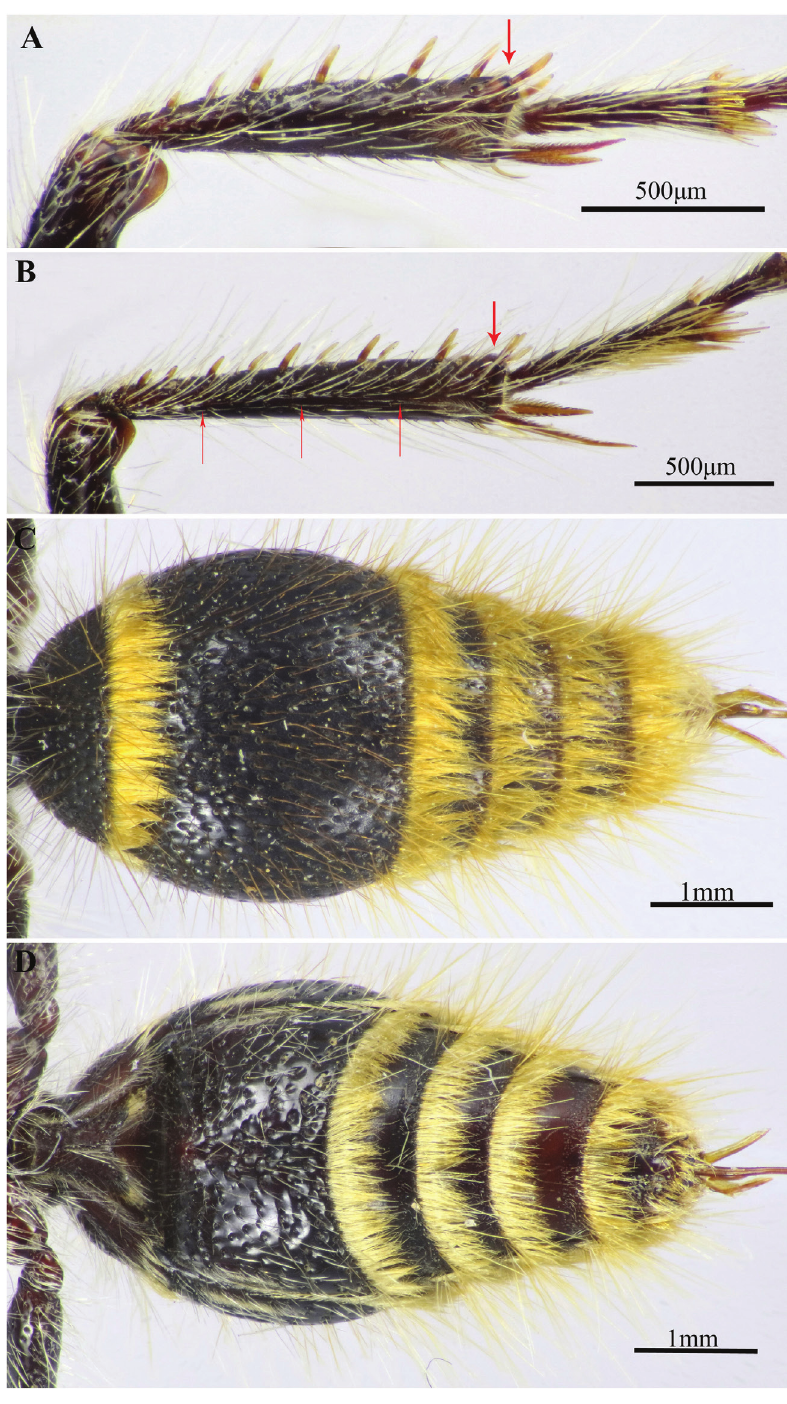
Figure 21. Pseudophotopsis mascatiana Invrea (Female) A, B mid and hind tibiae and basitarsomeres, re- spectively (apices of mid and hind tibiae indicated) C, D metasoma, dorsal and ventral views,